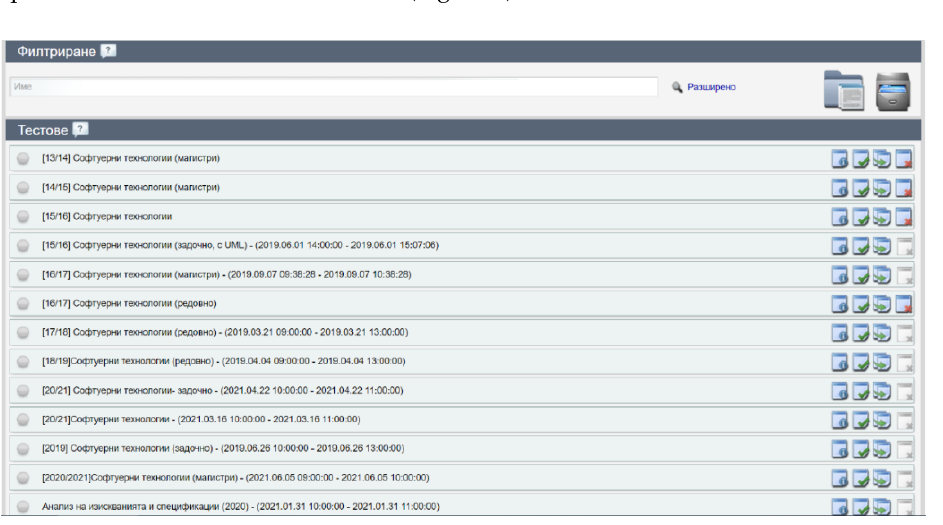
Figure 4. Selbo 2 editor (in Bulgarian).